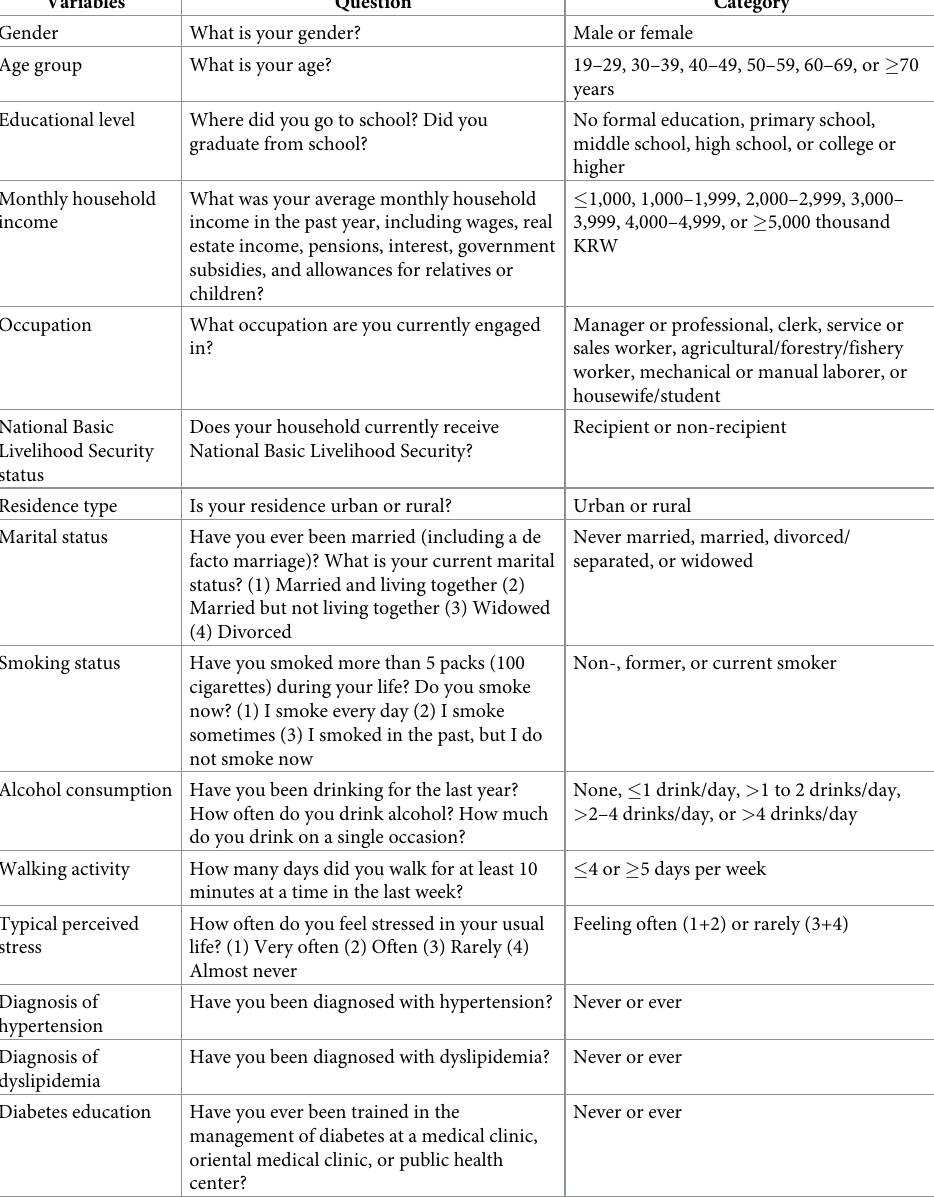
Table 1. Summary of independent